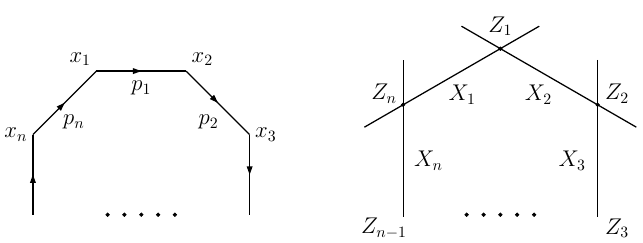
Figure 4 . Diagrams indicating the relation between momenta p i , dual variables x i and momentum twistors Z i